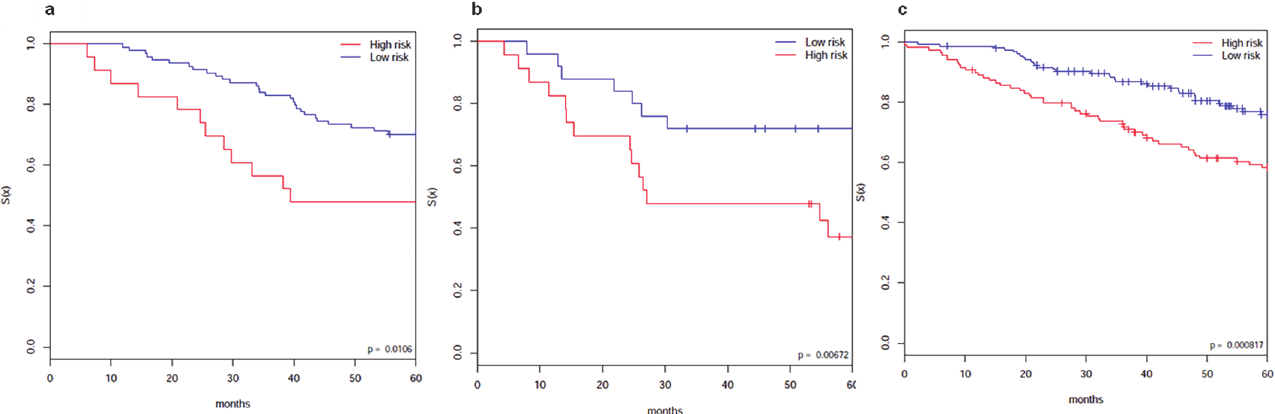
Fig 5. Independent verification testing of the 128 identified genes. Testing of the 128 identified genes on the ACC (a) and the GSE5843 dataset (b). Kaplan-Meier plots of the clusters of the samples show statistically significant survival differences, with p-value = 0.0106 for the ACC dataset, and p-value = 0.00672 for the GSE5843 dataset. For each verification test, the separation of the samples is from MBI running with parameter k 2 = 2 on the corresponding rows of the dataset (i.e., using only the part of Y matrix of ACC or GSE5843 that corresponds to the 128 genes). (c) Testing of the 128 identified genes on Jacob stage1. The separation of the samples is from MBI running on the corresponding rows of the dataset with parameter k 2 = 2. Kaplan-Meier plot of the sample clusters show statistically significant survival differences, p-value = 0.000817.